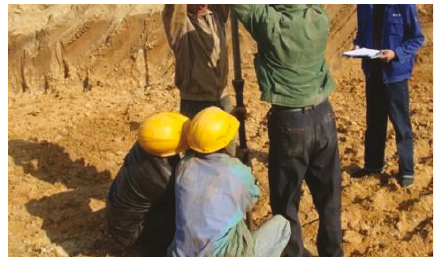
Figure 10: Dynamic sounding test ( E